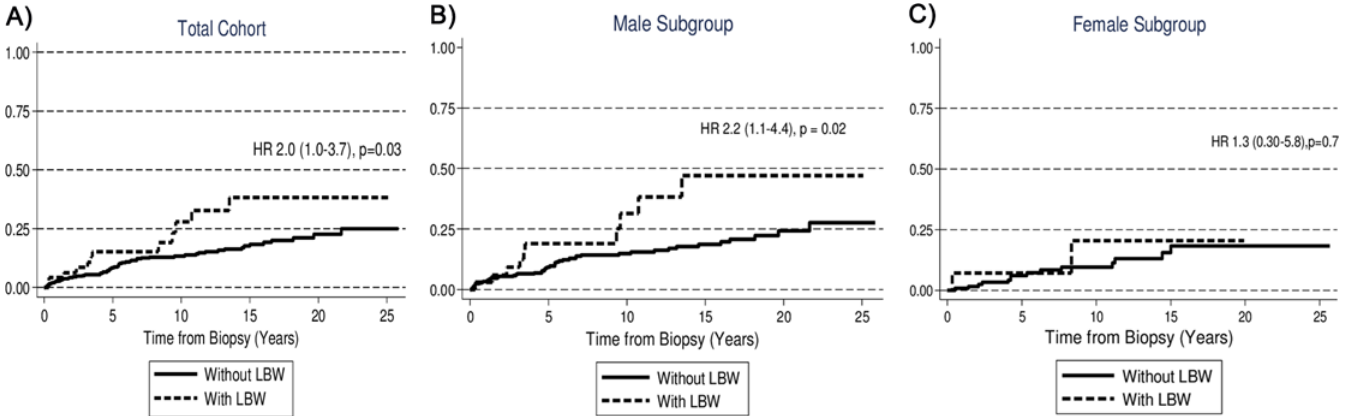
Fig 1. Cumulative Probability of ESRD in patients with IgAN according to whether or not the patient had